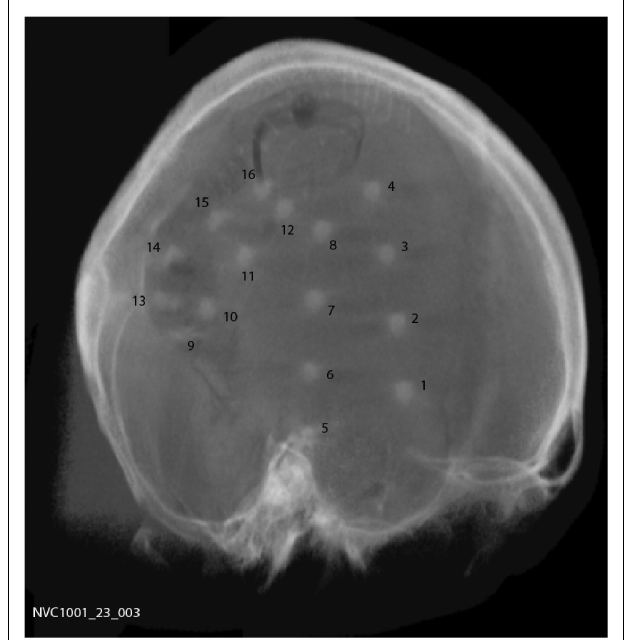
FIGURE 1 | Plain skull radiograph of subject post implantation, showing typical implantation scheme